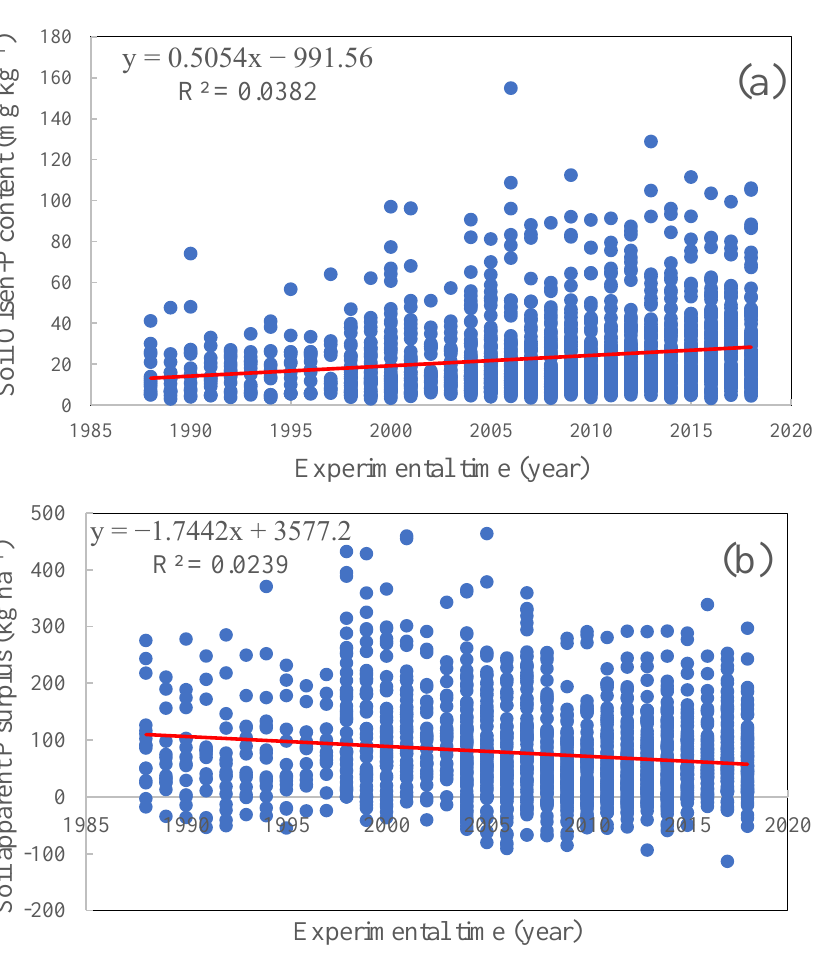
Figure A2. Soil Olsen-P content ( a ) and apparent P surplus ( b ) over time under 91 long-term fertilization experiments.